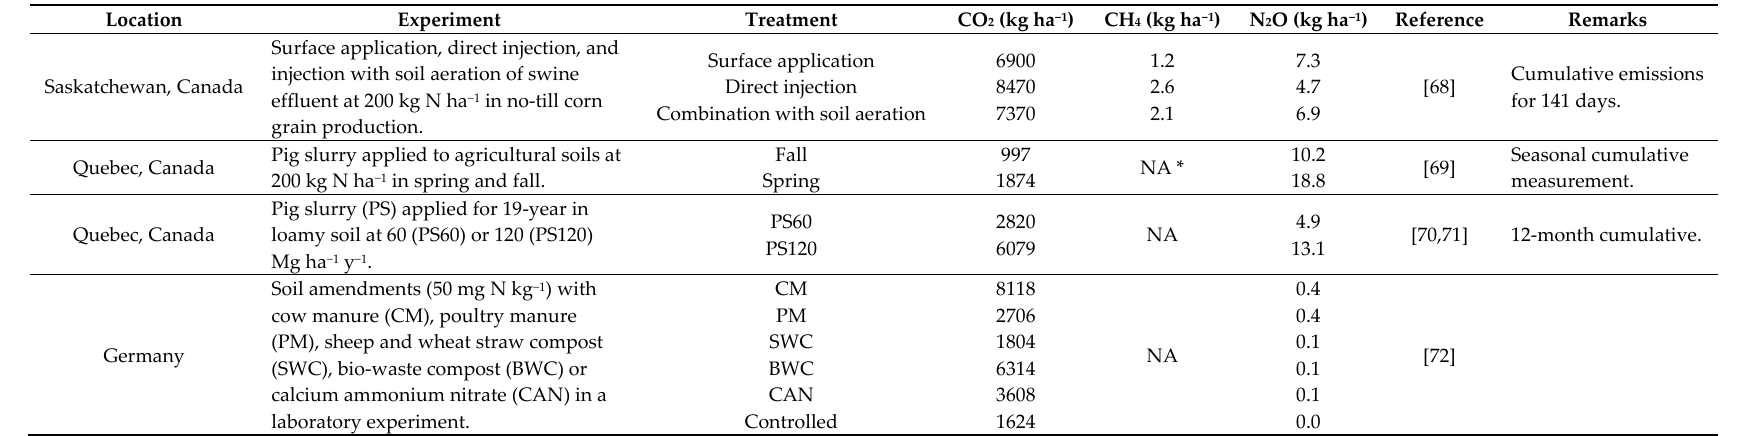
Table 3. Summary of the previously documented effects of applying raw manure, composted manure, or manure pellets on subsequent C sequestration and GHG emissions in croplands and grasslands.